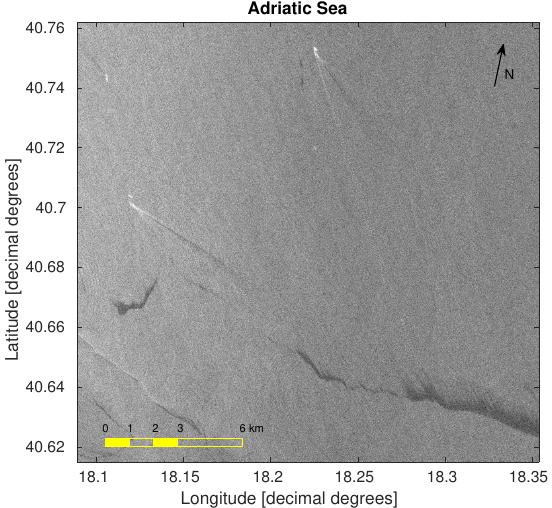
Figure 3. CSK StripMap HIMAGE of the southern Adriatic Sea before morphological processing (image not rotated into the Lat-Lon grid).